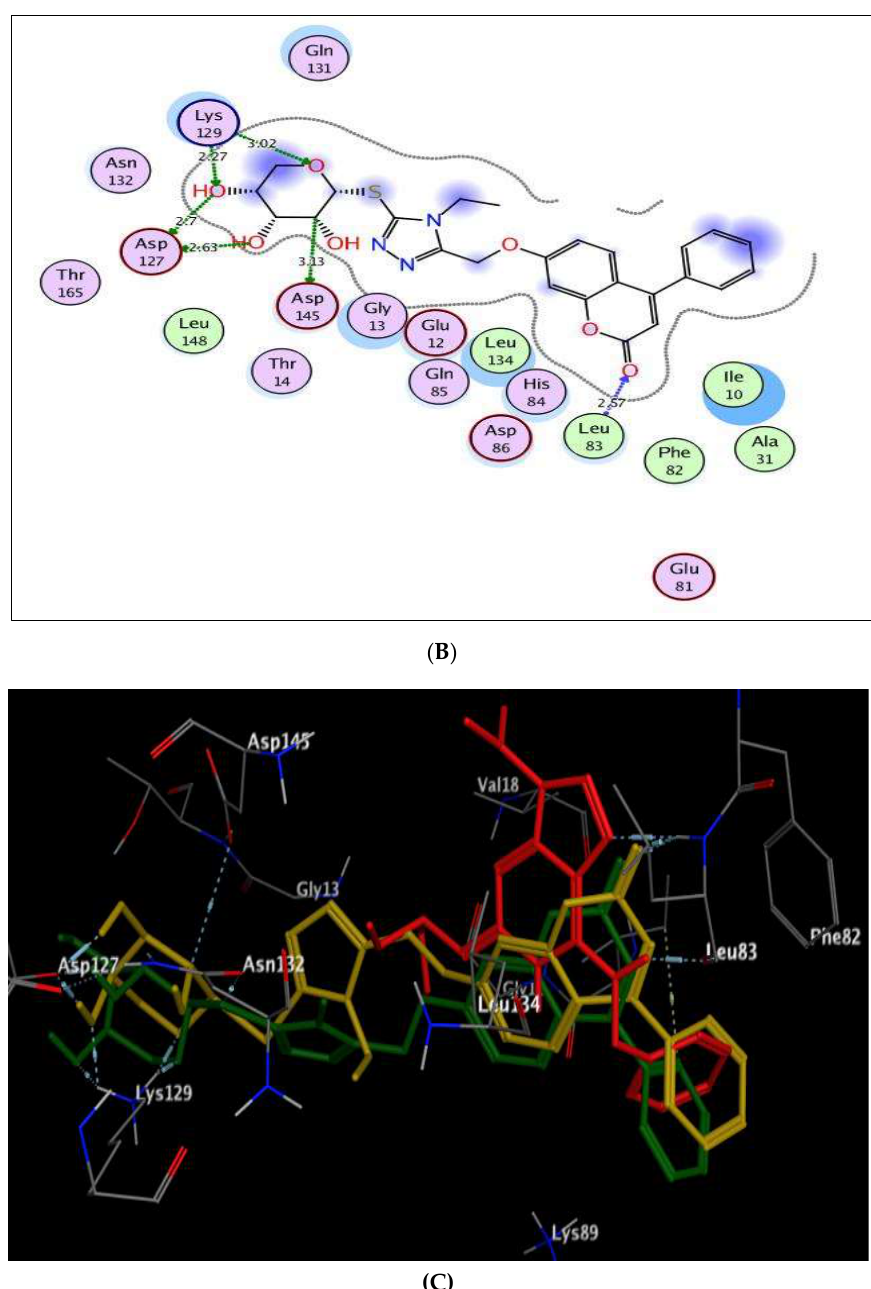
Figure 8. ( A–B ) views illustrate the 2D binding features of the coumarin targets, 8 and 10 , while ( C ) view illustrates the 3D superimposition between the original ligand roscovitine (red), 8 (green) and 10 (yellow) within the active site of CDK-2/cyclin A2 (PDB code: 3DDQ), respectively.